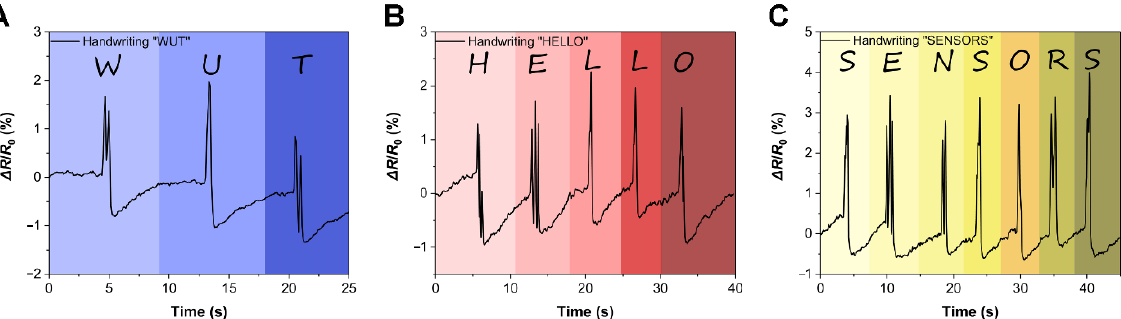
Figure 7. The PVA/GO flexible writing keyboard responding to the written English letters in real- time. ( A ) “WUT”. ( B ) “HELLO”. ( C ) “SENSORS”. ( A ) “WUT”. ( B ) “HELLO”. ( C )